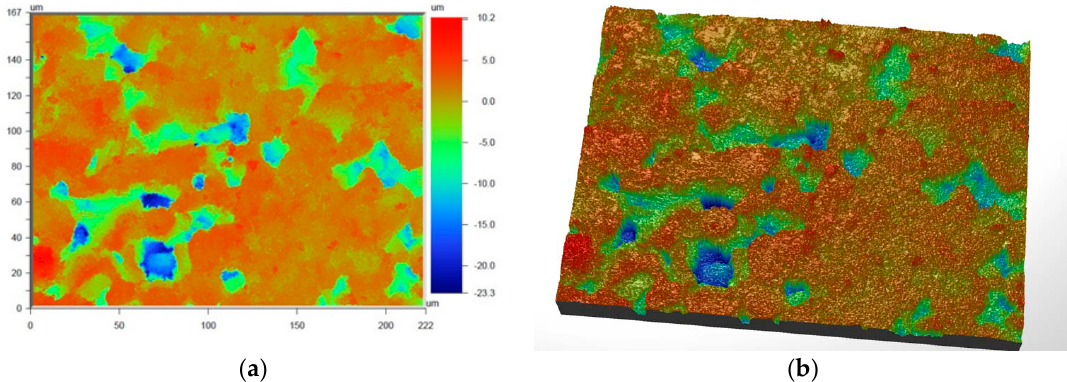
Figure 15. 2D ( a ) and 3D ( b ) profilographs of PW3 sample at a magnification of ×11.5.